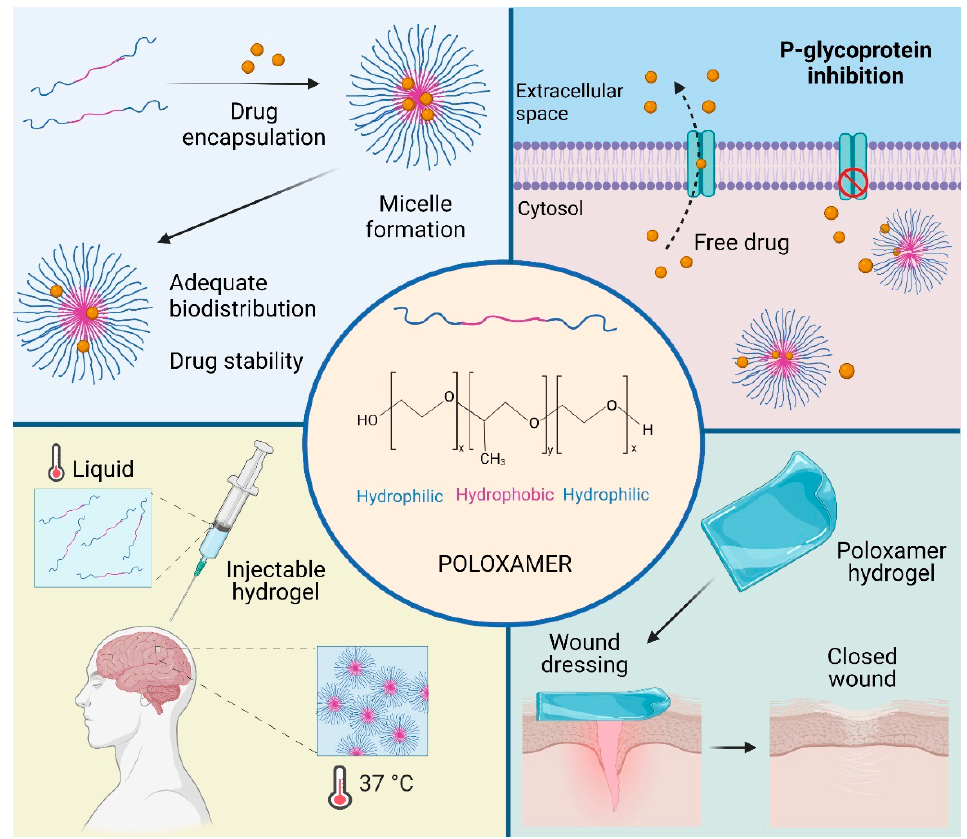
Figure 3. Poloxamer applications. Poloxamers could be used in several fields according to their biological and physicochemical properties. For example, micelles are effectively used as drug carriers. Moreover, they presented the ability to inhibit drug efflux transporters. Poloxamers represent an attractive alternative to tissue engineering, both as injected hydrogel, exploiting their thermosensitivity capacity, and structured hydrogel for wound dressing.